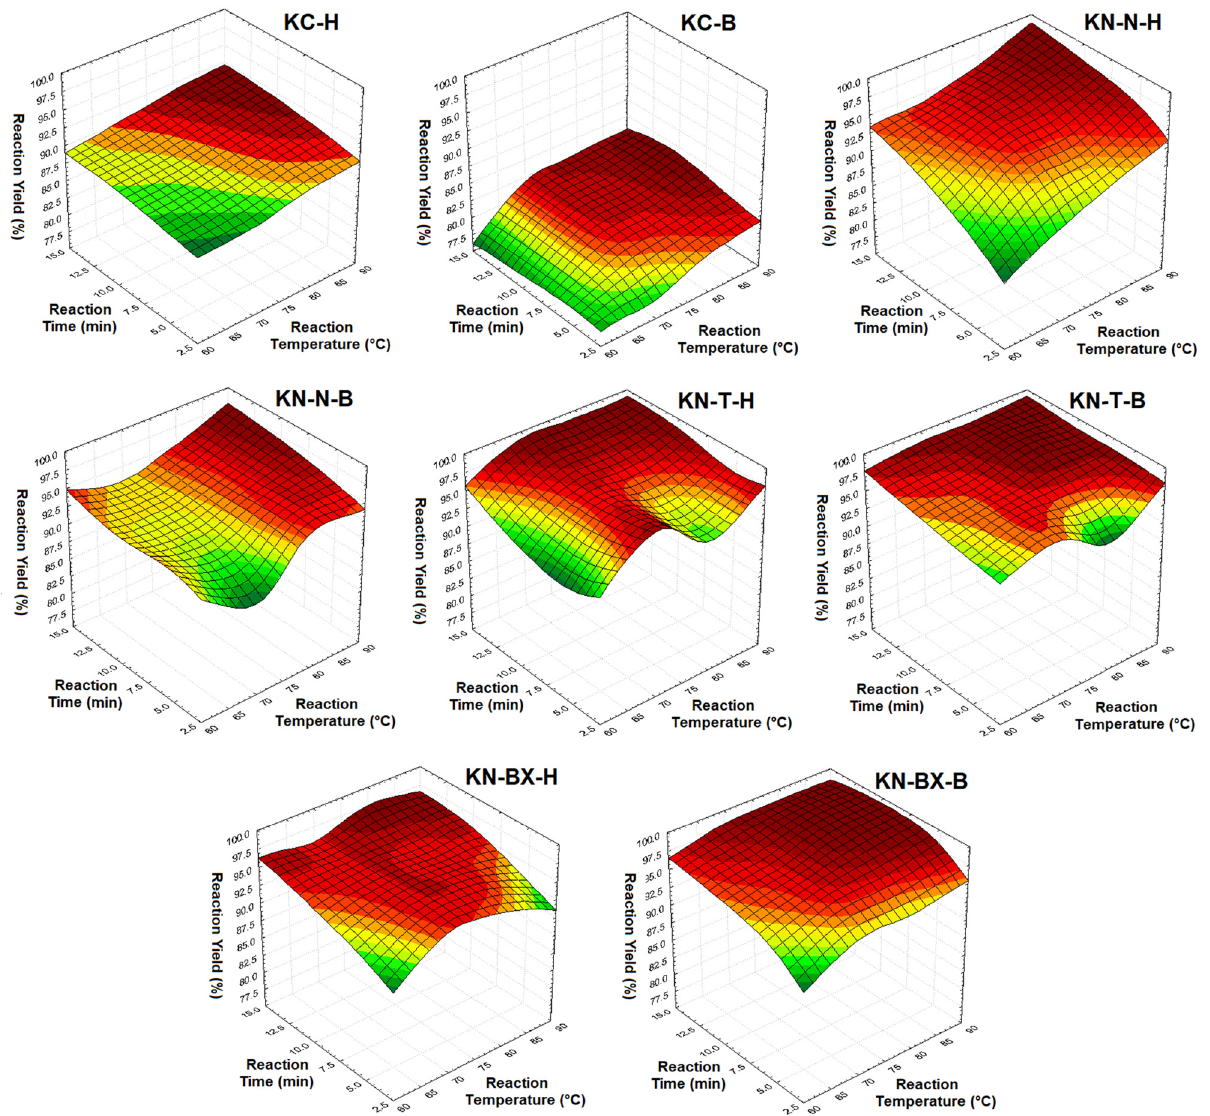
Figure 3: Overall reaction yields of santite synthesized in di ff erent